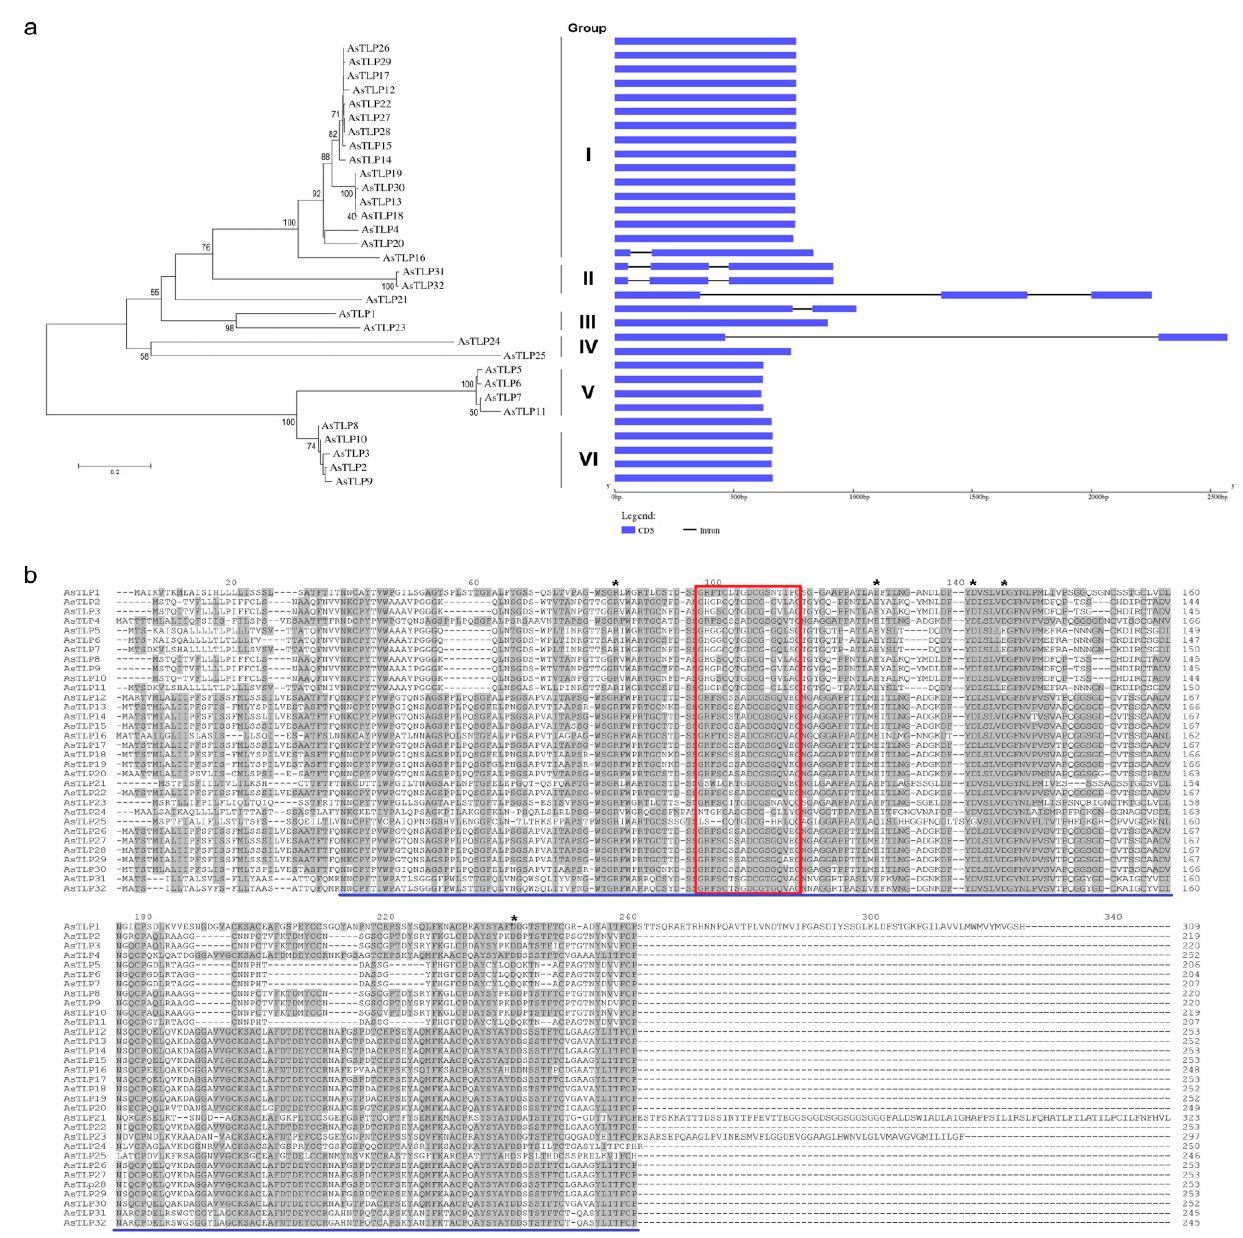
Figure 2. Phylogenetic and structural analysis of AsTLPs. ( a ) Evolutionary relationship based on amino acid sequences and exon-intron structures of the AsTLP genes. The unrooted dendrogram was constructed in MEGA 7.0.26 using the Neighbor-Joining method (bootstrap test: 1000 replicates). ( b ) Sequence alignment of AsTLPs. Regions with 50–100% identity are grey-shaded. The con- served thaumatin domain (GH64-TLP-SF; pfam00314) is underlined blue, the TLP family signature GX[GF]XCXT[GA]DCX(1,2)GX(2,3)C (PS00316) is framed red, and REDDD motif residues are marked with